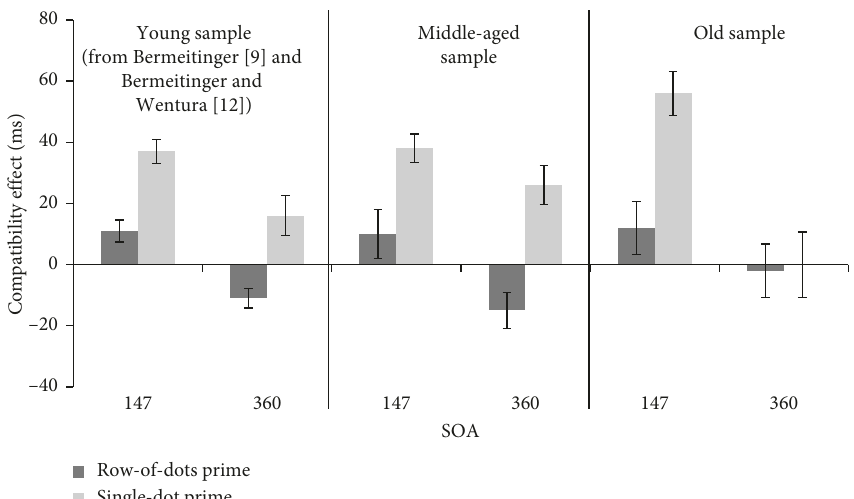
Figure 2: Mean compatibility effects (mean RT incompatible–mean RT compatible) from the 147 and 360ms SOA condition, separately depicted for the middle-aged and old samples. For reasons of comparison, we added the corresponding priming effects from young samples from experiments published in previous papers with the same conditions as in the current experiment (for the single-dot condition from [12], Exp. 1; for the row-of-dots condition from [9], Exp. 3); error bars represent the standard error of the